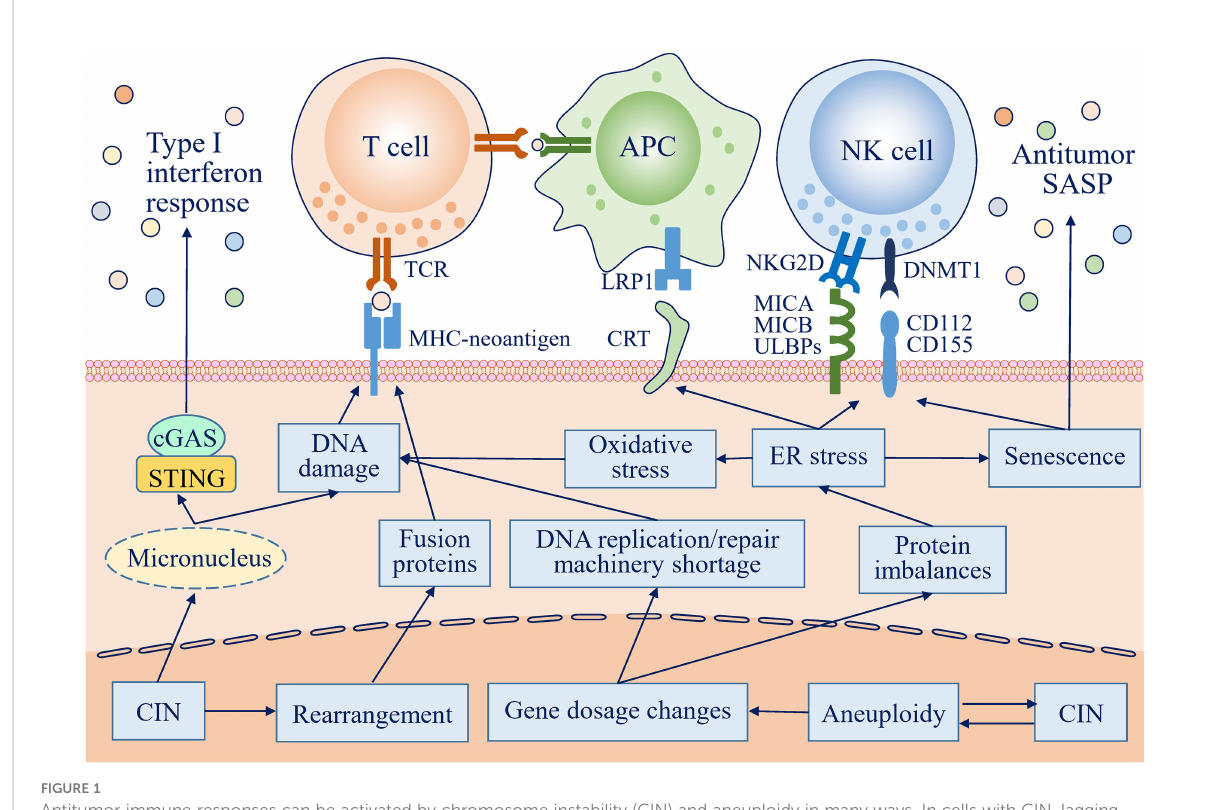
FIGURE 1 Antitumor immune responses can be activated by chromosome instability (CIN) and aneuploidy in many ways. In cells with CIN, lagging chromosomes form micronuclei, which are prone to rupture, and DNA is then exposed to the cytosol to activate the cGAS-STING pathway, further inducing an antitumor type I interferon response. Gene dosage changes resulting from CIN/aneuploidy lead to protein imbalances, followed by endoplasmic reticulum (ER) stress. ER stress increases the expression of activating natural killer (NK) cell ligands and redistributes endogenous calreticulin (CRT) to the surface of the plasma membrane, which are recognized by and activate NK cells and antigen-presenting cells (APCs), respectively, to eliminate transformed cells by innate and adaptive immune responses. ER stress also promotes cells with CIN/ aneuploidy to acquire a senescence phenotype and to secrete a broad range of mediators to create an antitumor immunoenvironment. In addition, DNA damage resulting from a replication/repair machinery shortage, exposure to the cytosol, and oxidation, along with complicated DNA rearrangement, can increase the immunogenicity of CIN/aneuploid cells by creating many potential